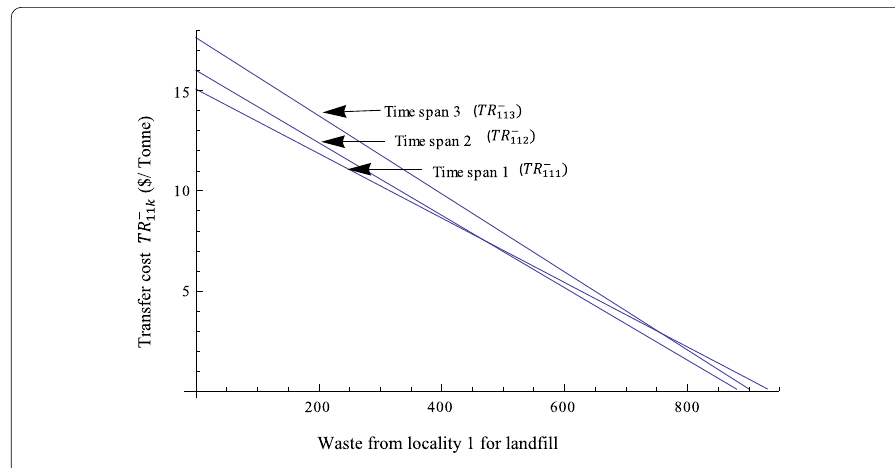
Figure 3 Lower bound of waste collection and transfer cost from locality 1 to the landfill